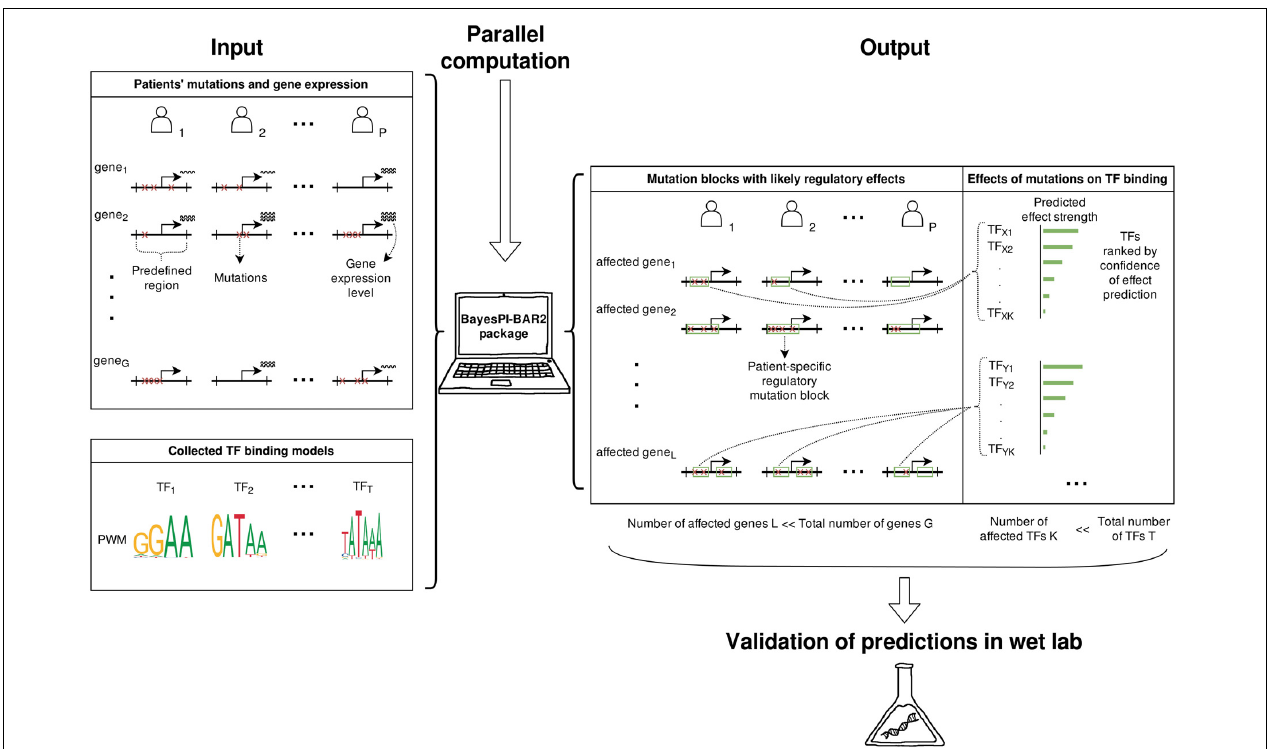
FIGURE 1 | Overview of the BayesPI-BAR2 operation. Using patients’ mutation and the corresponding gene expression data, BayesPI-BAR2 finds mutation hotspots and patient-specific mutation blocks. Then, using a given set of PWMs for TFs of interest, it produces a list of significant TFs whose binding is potentially affected at mutation block. The predictions consider all available mutation data among patient samples, to which strict statistical tests are applied to determine the significance of predicted effects. As a result, the number of predicted effects is small enough for performing follow-up wet lab